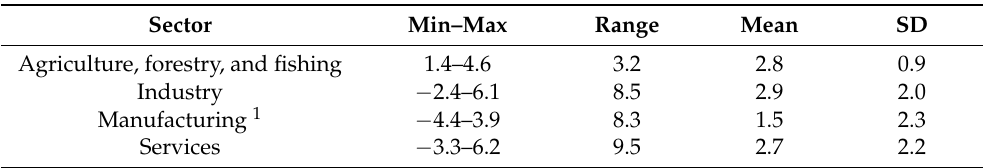
Table 1. Variability of the global value-added growth rates (%) by key sectors of the world economy Figure 6. The world GDP growth rates (%) and their variability in 2011–2021. in 2011–2021. Sector